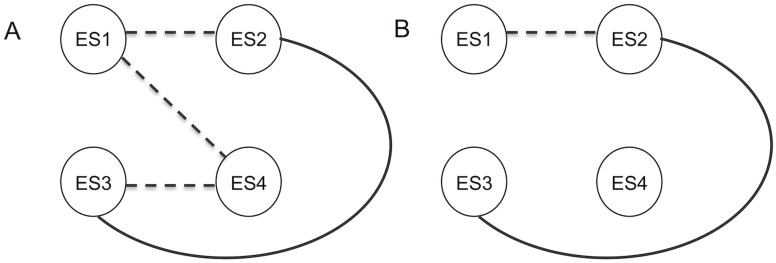
Hypotheses of integration and modularity for control eyespots based on overall phenotype data.A represents the most intergrated model inferring weak integration between neighboring eyespots and between eyespots 2 and 5 (for the black border). B represents the most conservative model showing weak integration only between eyespots 4 and 5. Broken line represents weak integration and the solid line represent strong integration.